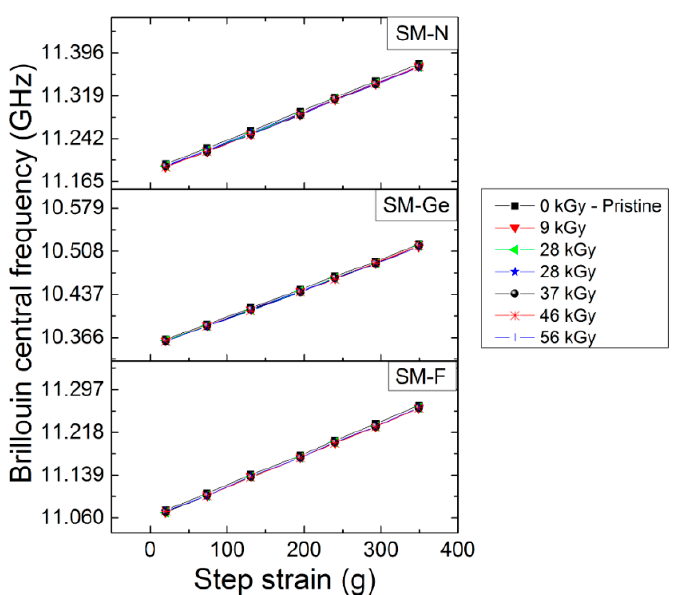
Figure 8. Evolution of Brillouin central frequency as a function of the applied stress for SM-F, SM-Ge and SM-N fibers, pristine and irradiated ones at different doses from 9 kGy to 56 kGy. Sensors 2017 , 17 , 396 10 of 15